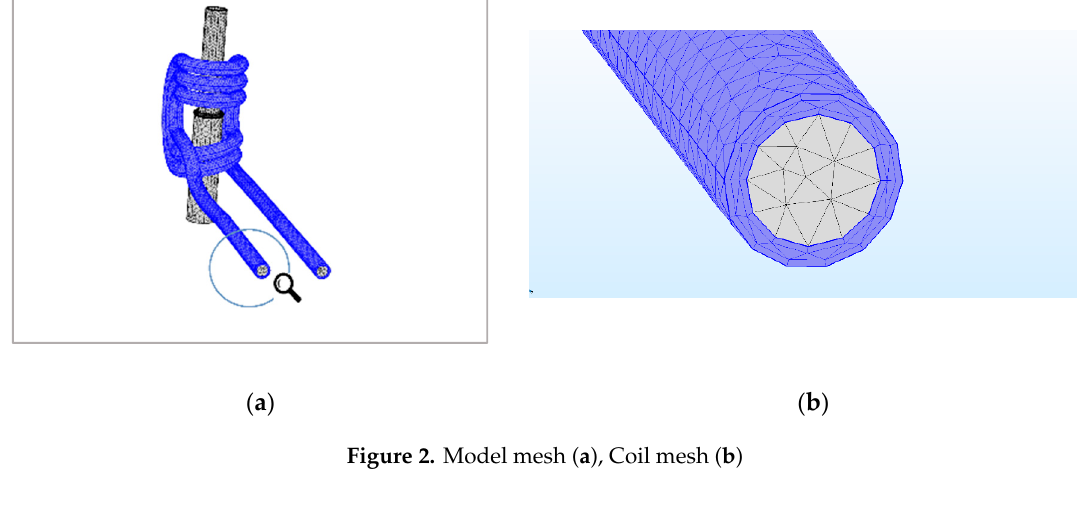
Figure 2. Model mesh ( a ), Coil mesh ( b )